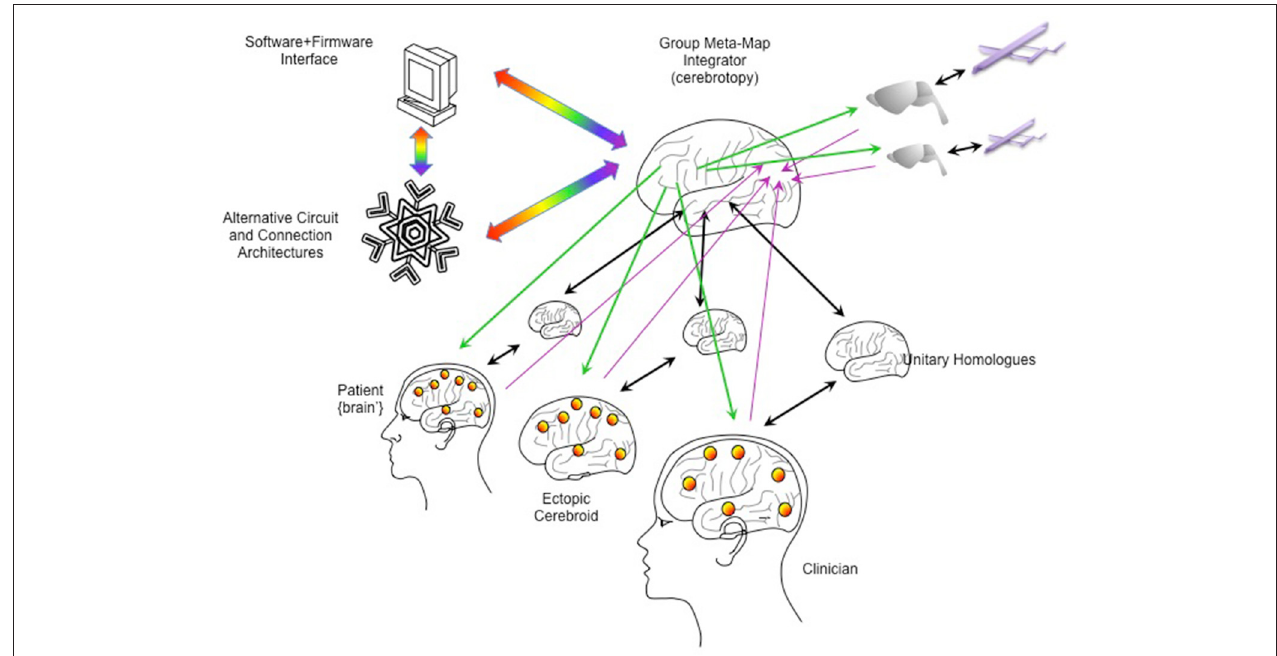
FIGURE 6 | Integrating multiple emulations. Multiple whole brain emulations can be linked together. In this scheme, the patient is linked reciprocally to a homologous emulation (as in Figure 5 ). An ectopic cerebroid (an organoid construct), itself instrumented with sensor/actuator interfaces, could be implanted into the patient, and could have its own dedicated homologous emulation. A clinician or therapist could guide calibration and rehabilitation through their own BCI interfaces and dedicated homologous. External robotics, such as semi-autonomous drones, could have simpler emulations (here shown as a model on a rodent brain). To coordinate all these emulations, a higher-order “meta-emulation” or “group meta-map integrator” could be forged with input/output connectivity based on principles of how single brains integrate information. Lavender arrows indicate inputs streaming into the “sensory” areas of the integrator, while green arrows indicate outputs streaming from the “motor” areas. Unitary homologs are reciprocally linked to “ventral what stream” temporal cortices, indicated by black arrows. Rainbow arrows indicate connectivity to software/firmware to mediate computer resource use and to explore novel computational